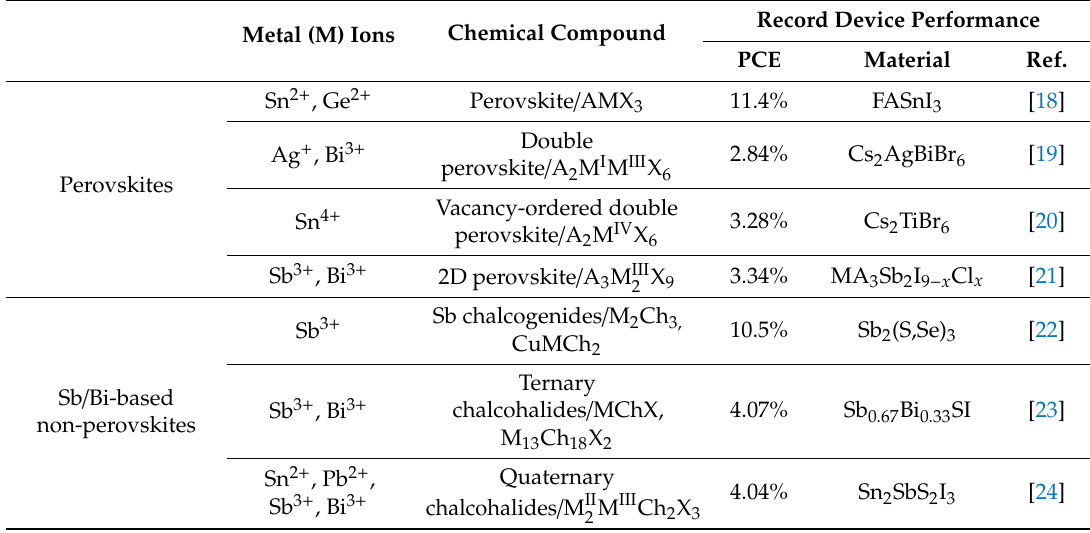
Table 1. Types of Pb-free photovoltaic materials and their best photovoltaic performance data. Metal (M) Ions Chemical Compound